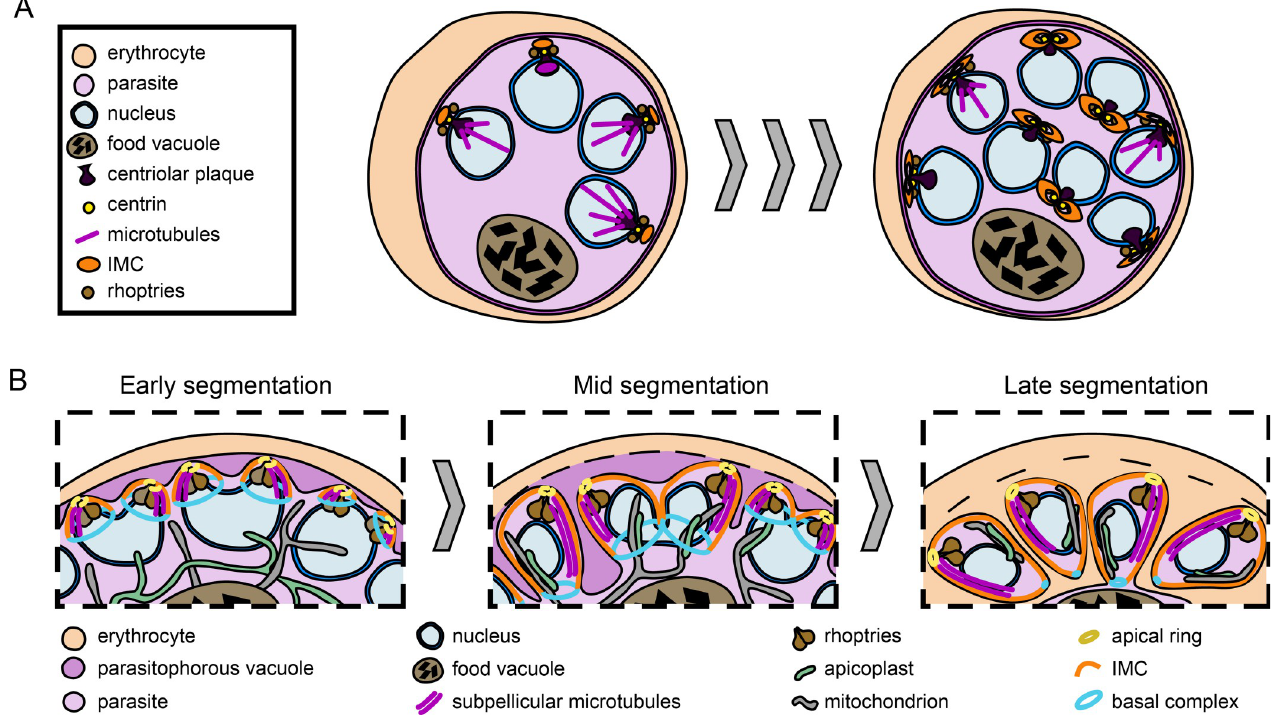
Fig 3. The end of nuclear multiplication and formation of daughter cells. (A) Structures and organelles involved in cytokinesis start forming during early nuclear cycles. Proteins of the IMC and the rhoptries start organizing around the centriolar plaque in cells with nuclei numbers as low as four and develop into larger structures as nuclear multiplication progresses. (B) Daughter cells are formed during segmentation. Concomitant to daughter cell formation, the nuclei are divided in a final, semisynchronous round of nuclear division. One pair of rhoptries associates with the apical end of the developing daughter cells. Segmentation commences when the plasma membrane (PM) starts invaginating. During segmentation, the IMC, which sits below the PM and originates from the apical end, starts enveloping the emerging daughter cell alongside the PM, with the basal complex localizing to the leading edge of the IMC. Concurrently to the expansion of the IMC, subpellicular microtubules start developing from the apical end of the emerging daughter cells. At the end of segmentation, the daughter cells now containing all necessary organelles are pinched off a remnant body containing the food vacuole.